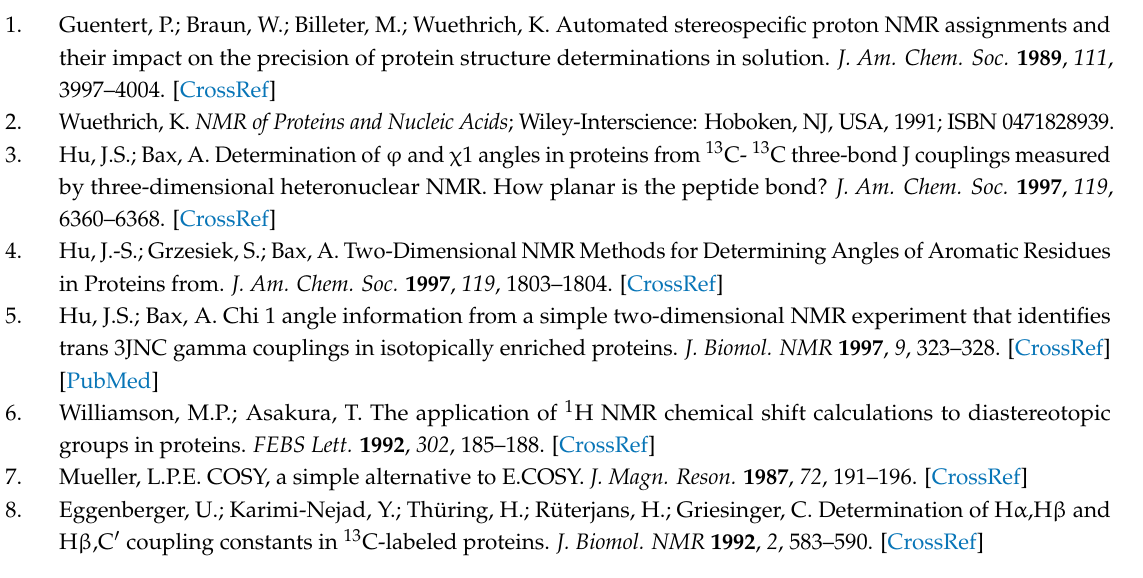
Figure S1: Correlation between linear sampling only and linear sampling with linear prediction for 3 J H α –H β coupling values in Pin1; Figure S2: Correlation between non-uniform sampling and linear sampling with linear prediction for 3 J H α –H β coupling values in Pin1; Figure S3: Circle plots showing χ 1 angles for the 20 CYANA Pin1 structures with the lowest target-functions on a per-residue basis. Angle distributions of structures calculated from eNOE and J-couplings without stereospecific assignment are in black, while those from stereospecifically assigned eNOEs and J-couplings are in red. Circle plots in blue are residues which were found to be stereospecifically assigned in our protocol; Table S1: Stereospecific assignments found in Pin1 using eNOEs and 3 J H α –H β coupling